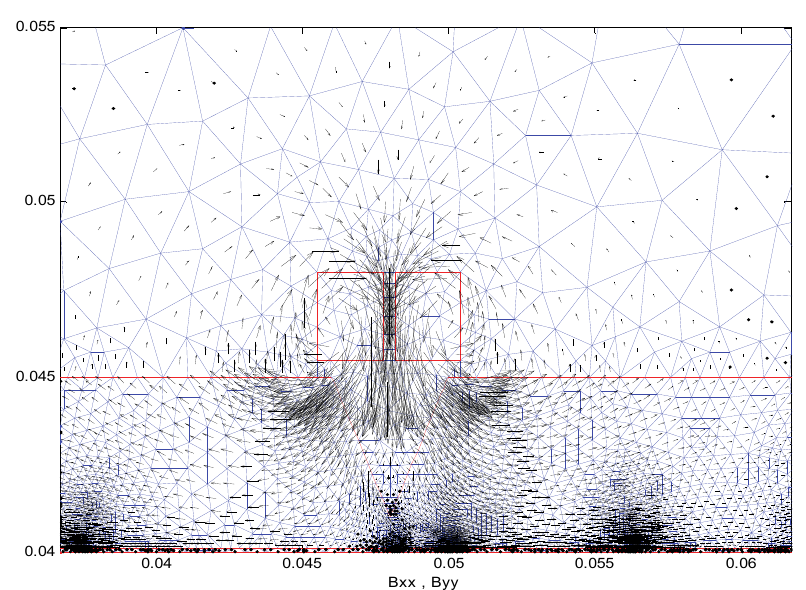
Figure 4: Representation of the vector of induction B.